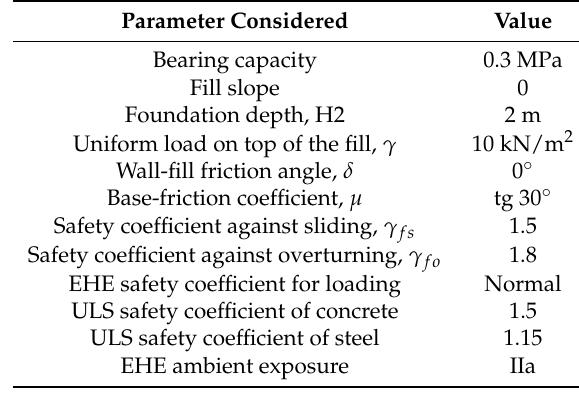
Table 3. Problem design parameters values.